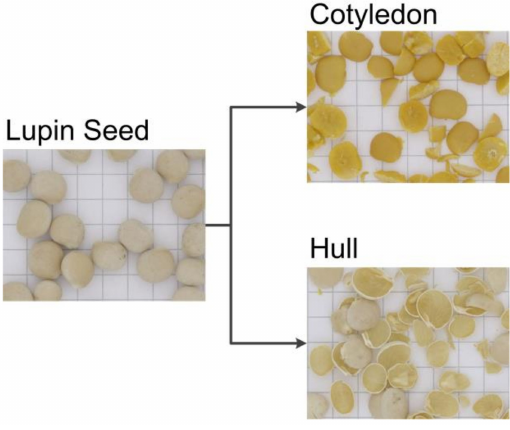
Figure 2. Seeds of L. angustifolius L.